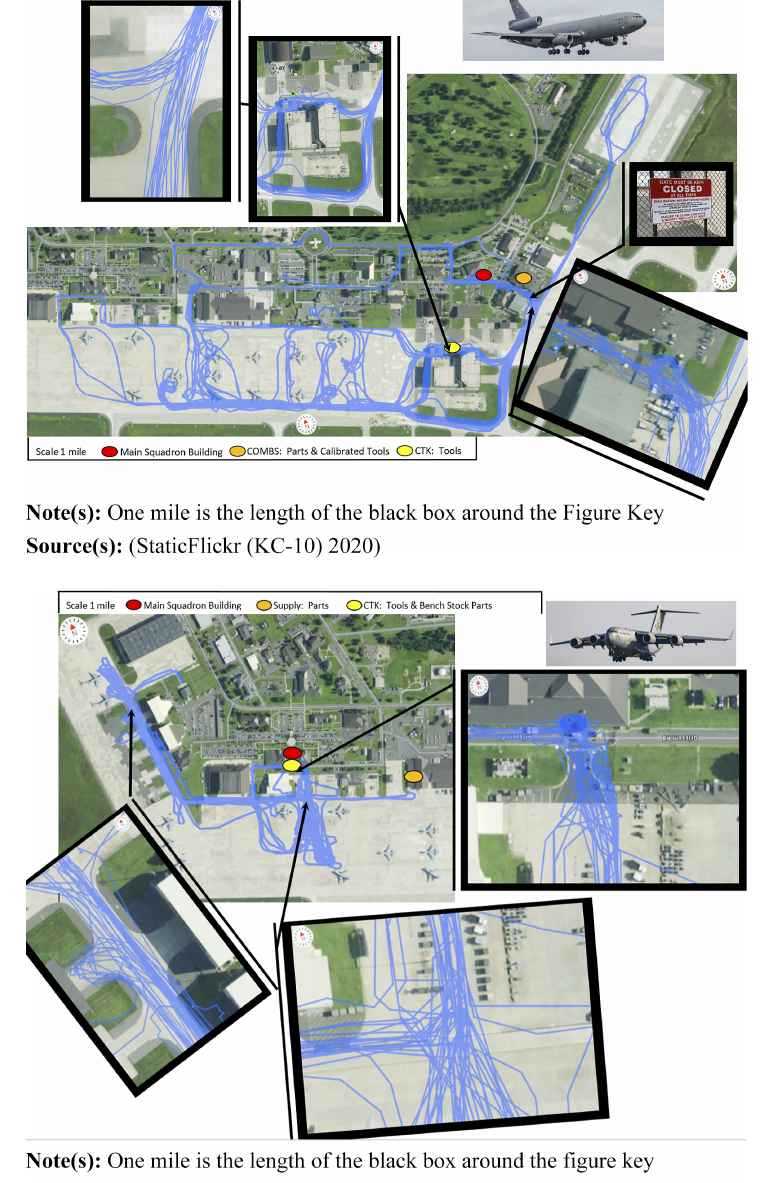
involves someone getting out of the expediter van, dragging the gate open, the driver pulling forward, and the individual closing the gate and climbing back inside the van. There is no gate in the area of operations for the C-17s.